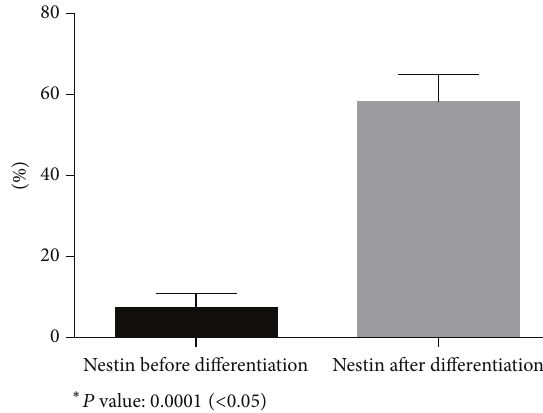
Figure 9: Comparison of nestin expression before differentiation and after differentiation.